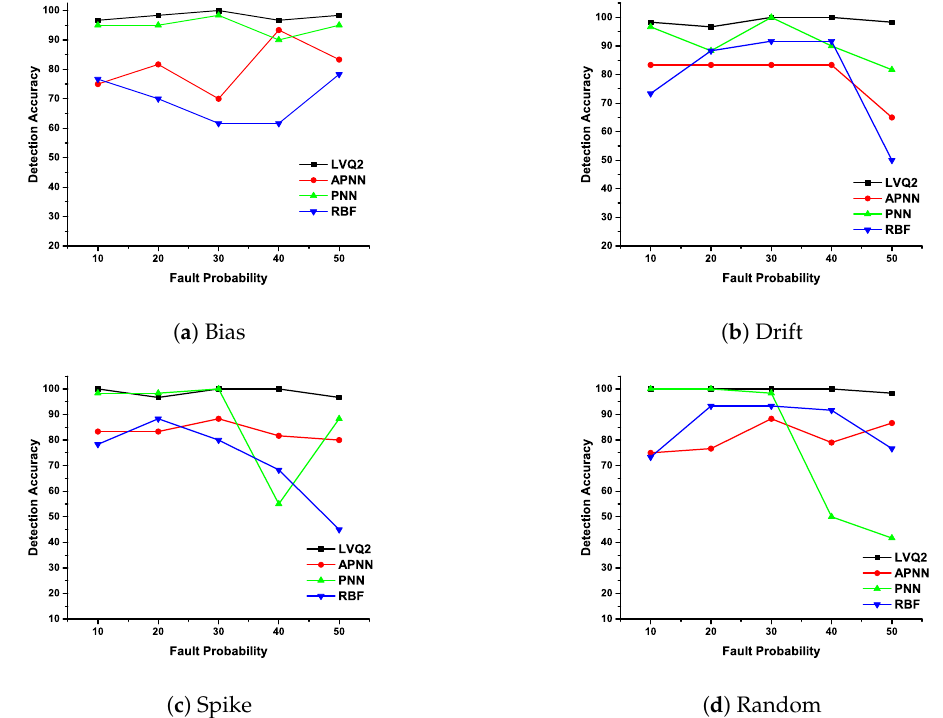
Figure 8. Detection accuracy of various faults with different neural networks